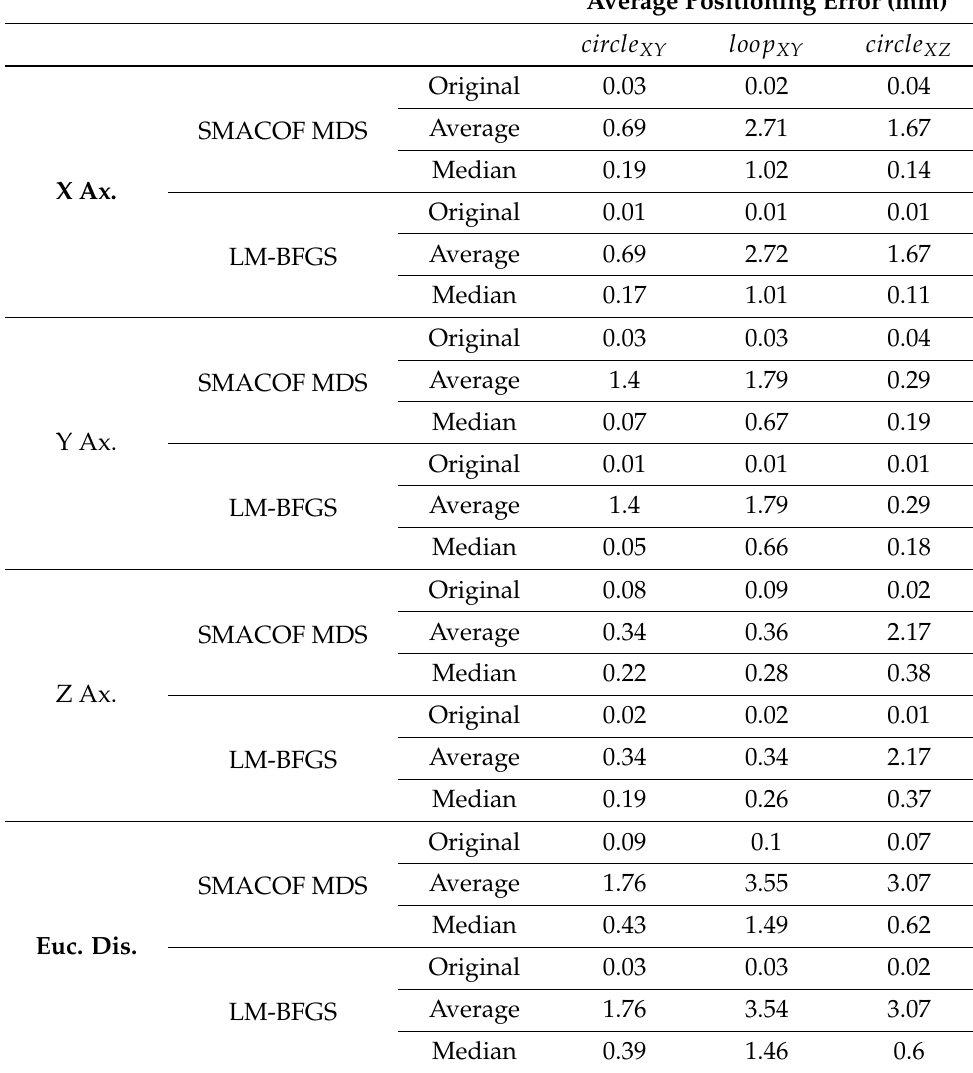
Table 3. Average trajectory error for the three different gestures without noise ( σ = 0 mm), with no smoothing (Original) and with 11th order ( M = 11) moving-average (Average) and moving-median (Median) smoothing filters, for SMACOF MDS and LM-BFGS optimization